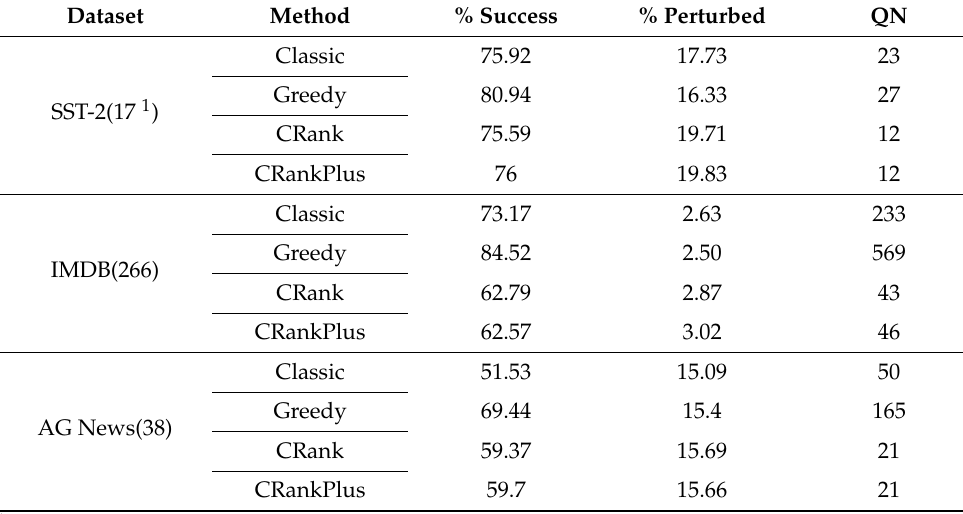
Table 10. Results of attacking various datasets. “QN” is query